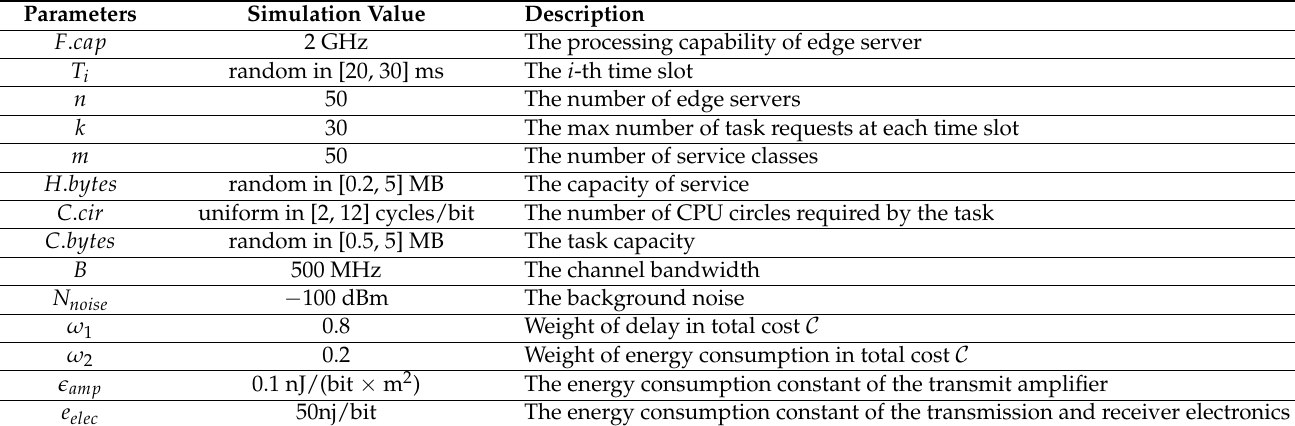
Table 1. Simulation